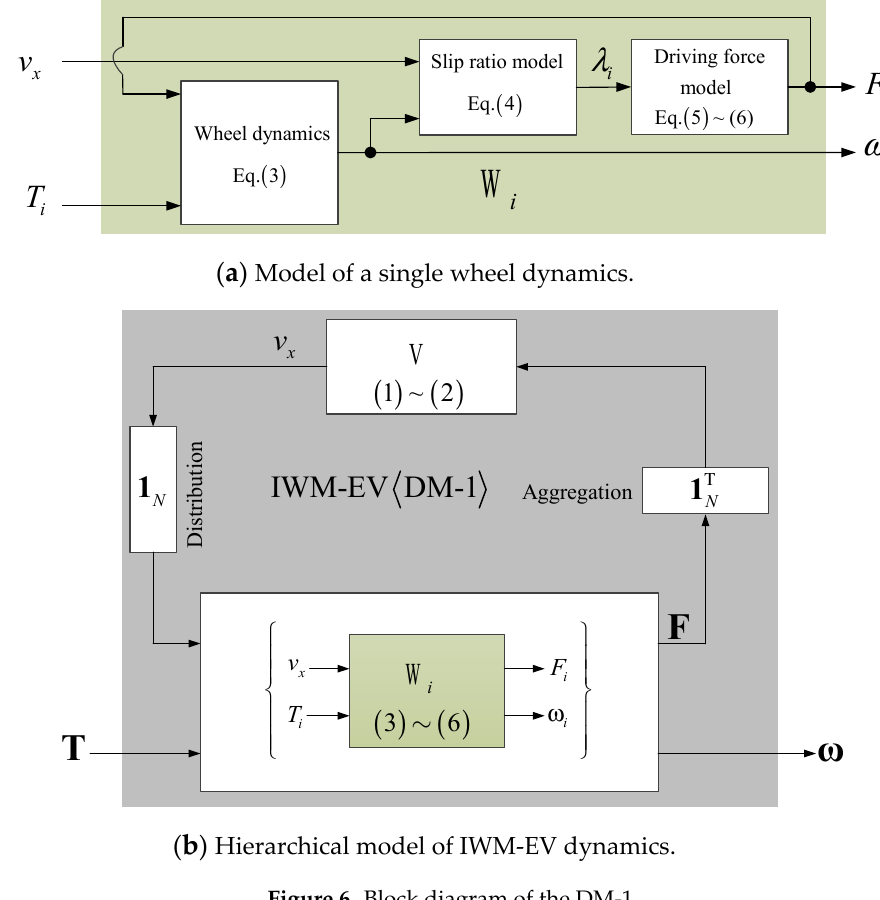
Figure 6. Block diagram of the DM-1.